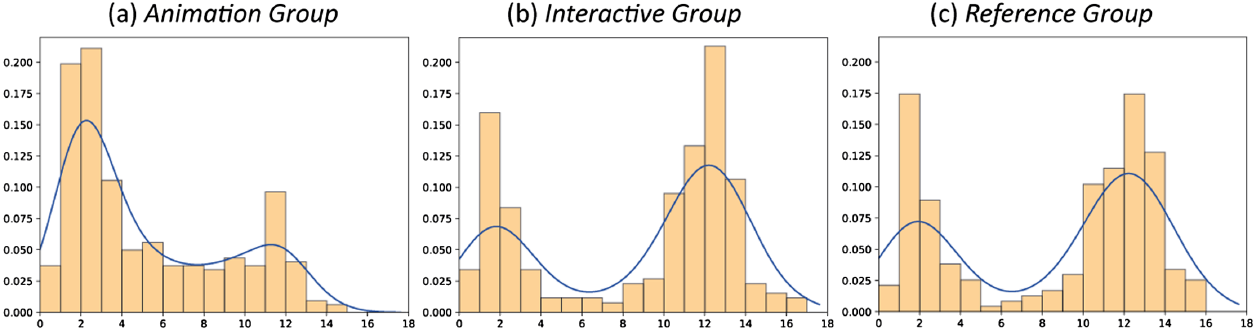
FIG. 9. The subfigures show the probability density function of saccades (blue line) in the angular field 345° – 15° according to their saccadic length (in cm) during training task 1 in the animation group (a), interactive group (b), and reference group (c). While in the animation group the probability for shorter saccades is higher than for longer saccades, the interactive group and reference group show the opposite